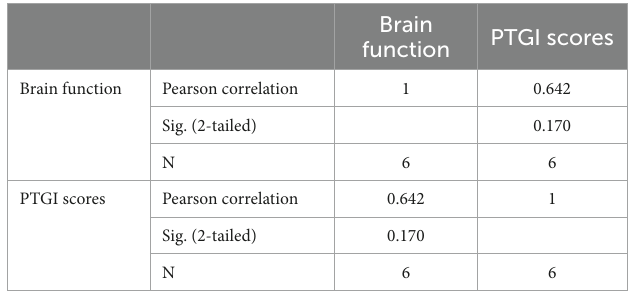
TABLE 3 Pearson correlation for brain function and PTG during CPT.